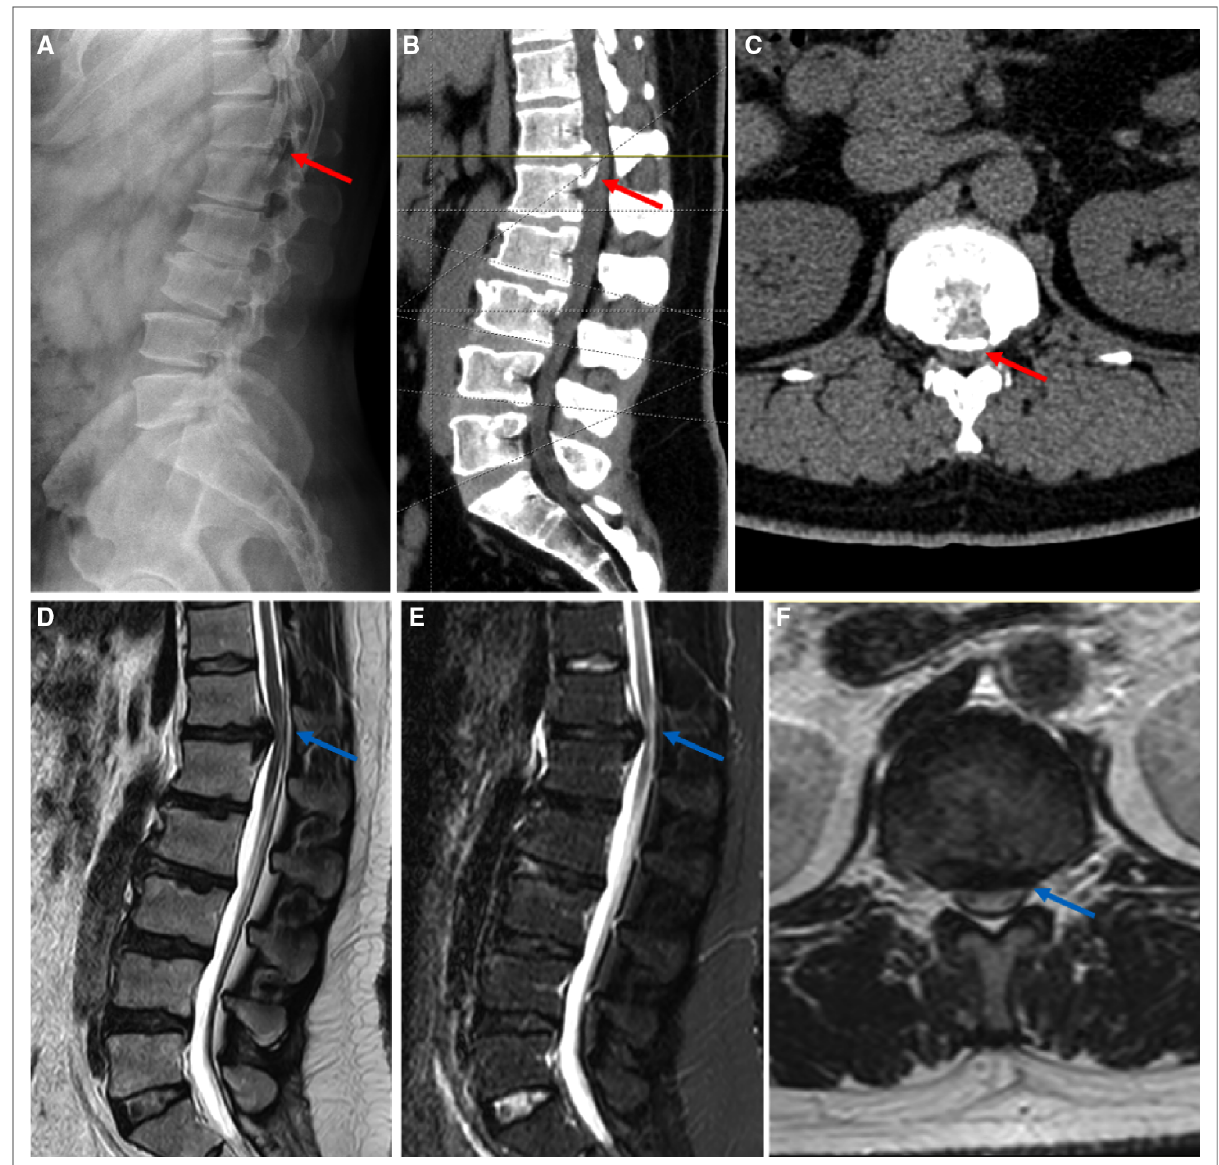
FIGURE 3 Preoperative imaging of the typical patient with disc herniation at the T12 – L1 level. A 38-year male patient diagnosed with TLDH with calci fi cation at the T12 – L1 level underwent PETD under general anesthesia. ( A – C ) Preoperative x-ray and CT. The red arrow in ( A – C ) highlighted calci fi ed herniated disc and ossi fi ed posterior longitudinal ligament. ( D – F ) Preoperative MRI. The blue arrows in ( D – F ) highlighted severe compression of spinal cord and the normal signal of cerebrospinal fl uid cannot be seen. ( A,B,D,E ) sagittal view; ( C,F ) axial view; TLDH, thoracolumbar junction disc herniation; PETD, percutaneous endoscopic transforaminal discectomy; CT, computed tomography; MRI, magnetic resonance